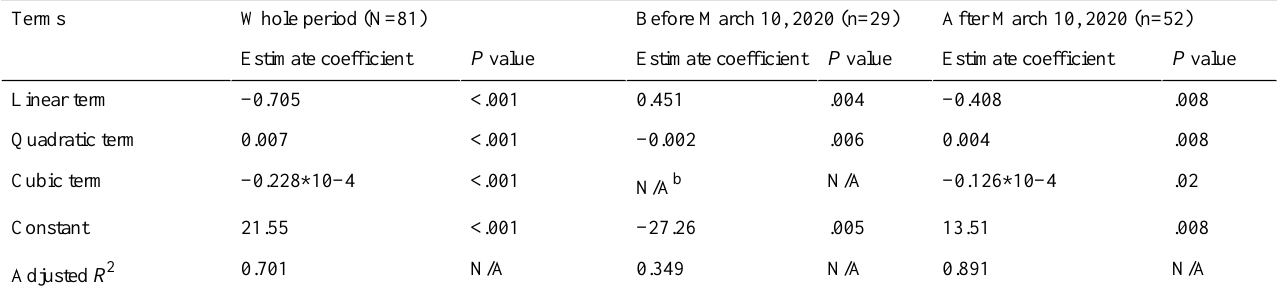
Figure 3. The correlation coefficient for the actual